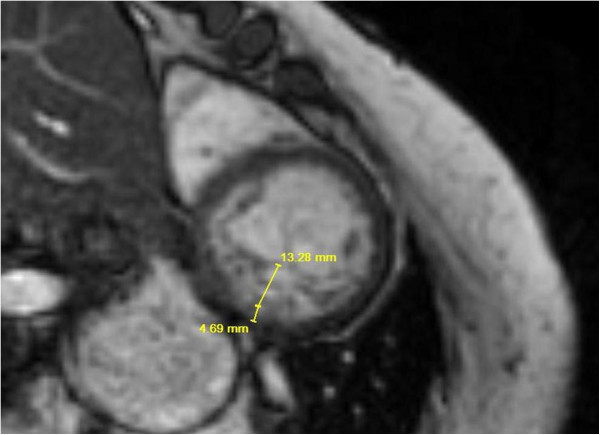
Example of measurement of noncompacted: compacted ratio in the short axis view of CMR of a DMD patient.